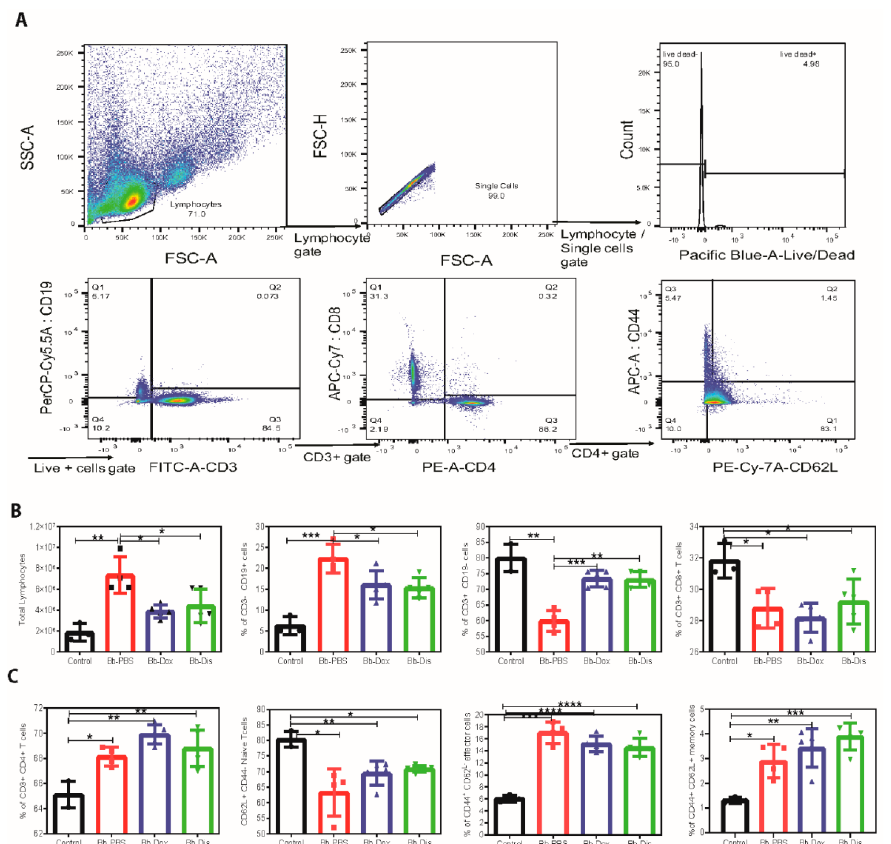
Figure 6. ( A ) Representative flow cytometry dot blot showing the gating strategy adopted for immuno-phenotyping of lymph nodes used in this study. ( B , C ) Percentage of B cells, T cells, CD8 + cytotoxic T cells, CD4 + helper T cells, naïve, e ff ector and memory CD4 + T cells in lymph nodes. Flow cytometry analysis of immune cells isolated from peripheral lymph nodes from uninfected and infected mice treated with antibiotics. Cells were labelled with anti-CD19, anti-CD3, anti-CD4, anti-CD8, anti-CD44 and anti-CD62L lineage surface markers. Statistics unpaired t -test with Welch’s correction between control versus infected and between drug-treated group versus infected group. * p < 0.05, ** p < 0.01, *** p < 0.001, **** p < 0.0001. NS means not significant.